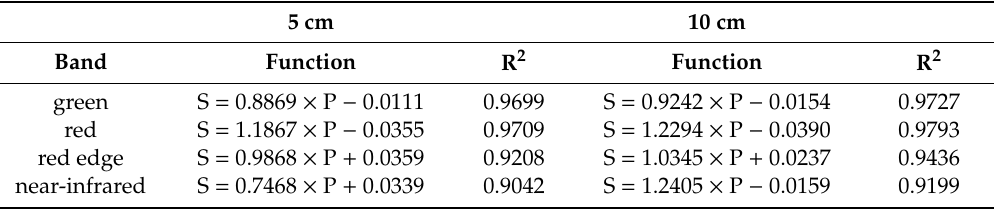
Table 5. Sequoia and P4M spectral value transformation functions and the values of their correlation coe ffi cients (R 2 ). 5 cm 10